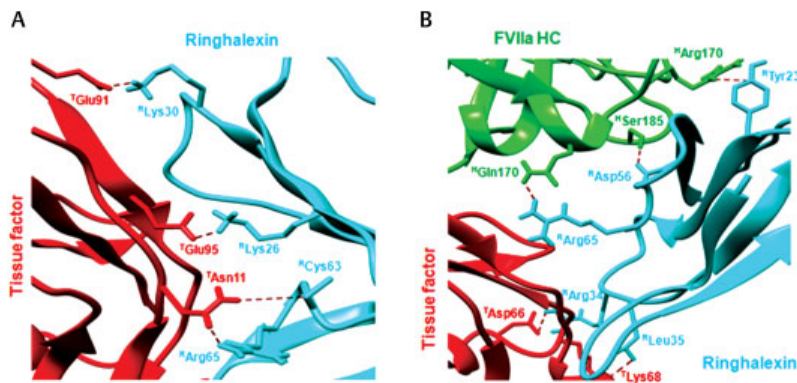
Fig. 7 Contact surface and binding interactions of ringhalexin. Ringhalexin residues involved in interaction with ( A ) TF and ( B ) TF-FVIIa. All proteins are shown as ribbon structures with interacting residues as sticks. Color codes: cyan, ringhalexin; green, FVIIa HC; red, tissue factor.